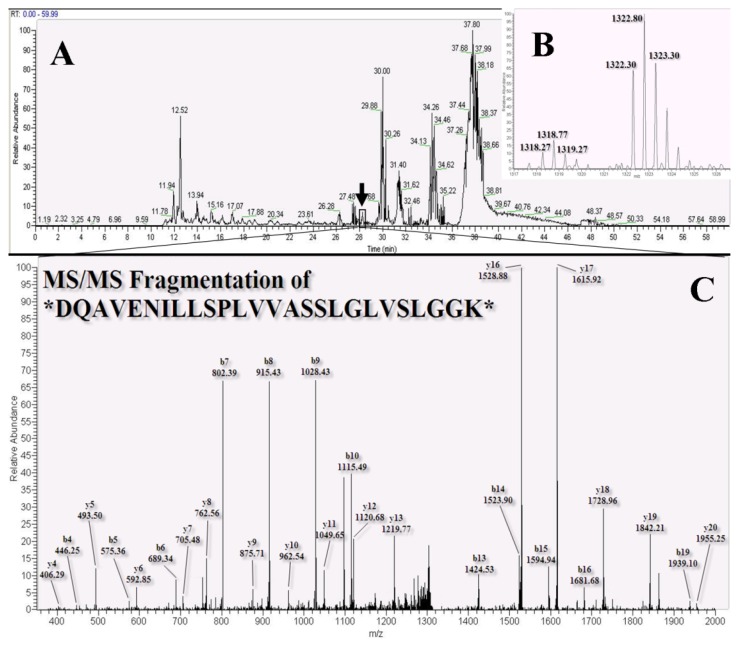
Nano-LC-MS/MS analytic spectra for tryptic digestion of epithelioid cell lysates of normal rat kidney (NRK-52E) cell lysates generated with disparate phthalic acid chemical probes (A) Base peak chromatograph of the NRK-52E binding peptides; (B) Mass spectrometric determination for summing 3 isotope peak areas of a peptide that was labeled with light (L, formaldehyde-H2) and heavy (H, formaldehyde-D2) isotopes showing the ratio of the DQAVENILLSPLVVASSLGLVSLGGK peptide with a 2+ charge; (C) Product ion scan spectrum of the peptide DQAVENILLSPLVVASSLGLVSLGGK (m/z 2642.58) that is found in serpin H1 protein. Asterisks indicate the amino acids generated by dimethyl labeling reagents, and the y-ions (C-terminal fragments) as well as b-ions (N-terminalfragments) are produced by fragmentation by the collision gas.